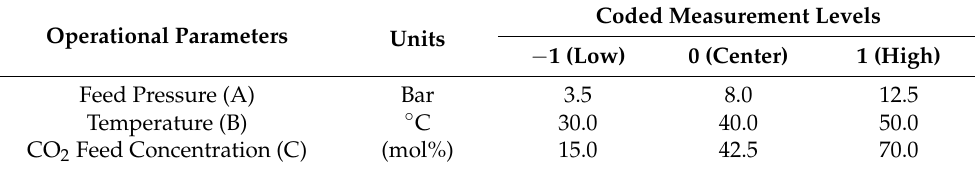
Table 1. Experimental range and levels of the operational parameters. Operational